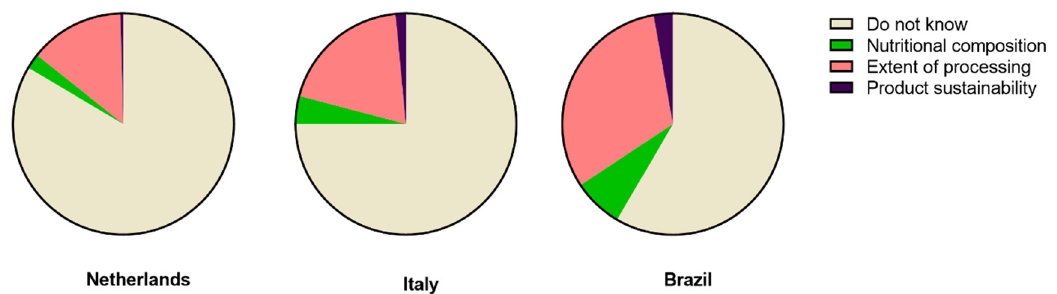
* All values are presented as percentage of consumers (absolute number of consumers).